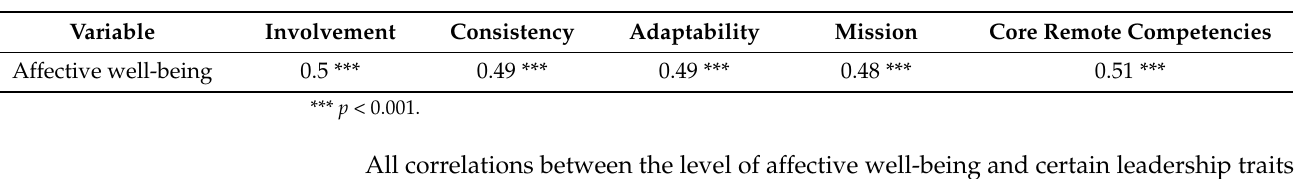
Table 4. Spearman correlations between leadership effectiveness traits, core remote competencies and affective well-being.